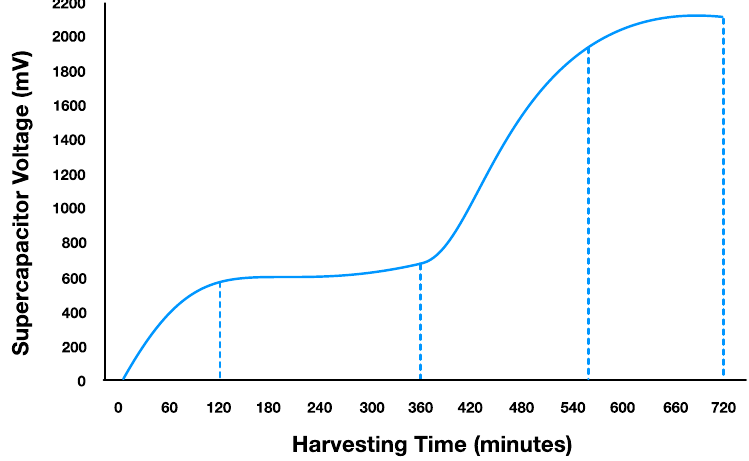
Figure 21. Charging time for a 220 mF SC under the testing environment.